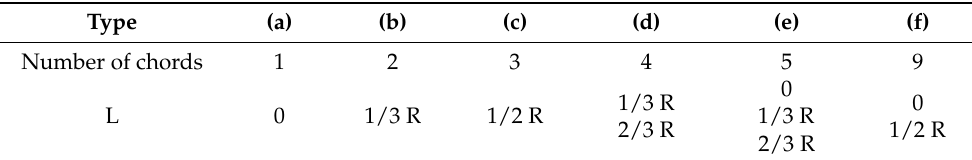
Figure 1. Basic acoustic path types for single- and multi-path meters: ( a ) one diametric; ( b ) two parallel one-third diametric; ( c ) three mid-radius; ( d ) four parallel; ( e ) five parallel; ( f ) mid-radius and diametric. Table 1. Basic acoustic path types for single- and multi-path